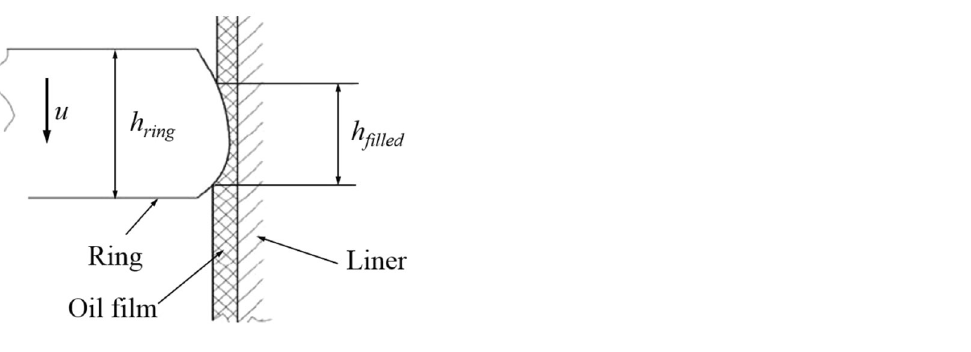
Figure 2. Oil filling